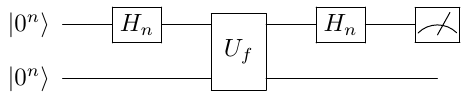
Figure 1: Quantum circuit Q Simon